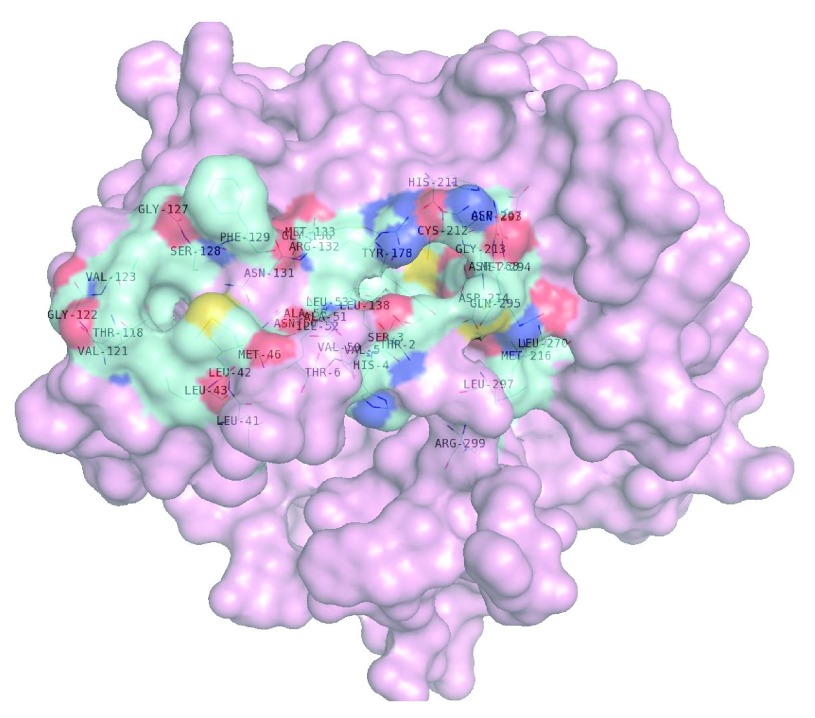
Binding site of the IPCS protein as predicted by Metapocket has been represented with carbon atoms in green, sulfur in yellow, nitrogen in blue and oxygen in red.